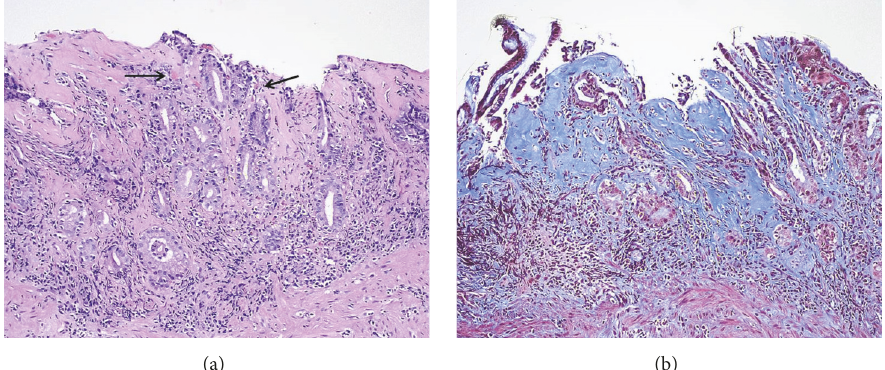
Figure 2: 20x magnification: (a) hematoxylin and eosin-stained section of the gastric body shows a thick, markedly irregular pink band of subepithelial collagen deposition with complete surface erosion. The mucosa is inflamed and atrophic with loss of parietal cells. Arrows indicate entrapped capillaries. (b) Trichrome stain highlights the collagen